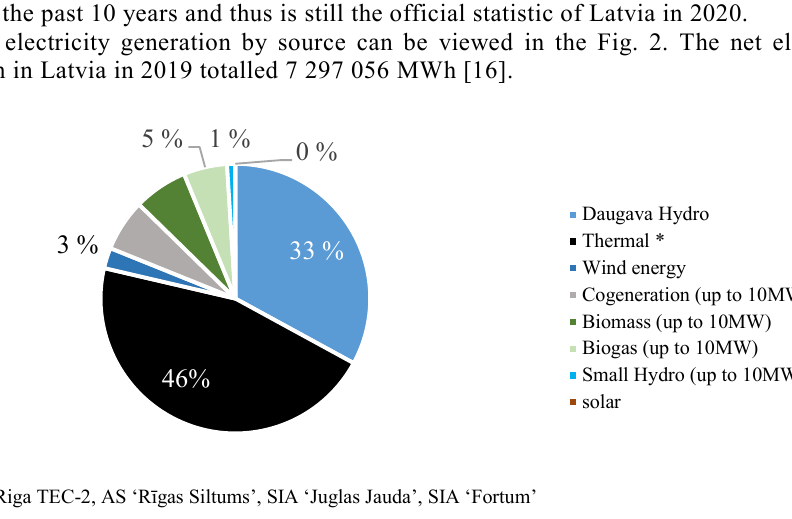
Fig. 2. Electricity generation in Latvia in 2019